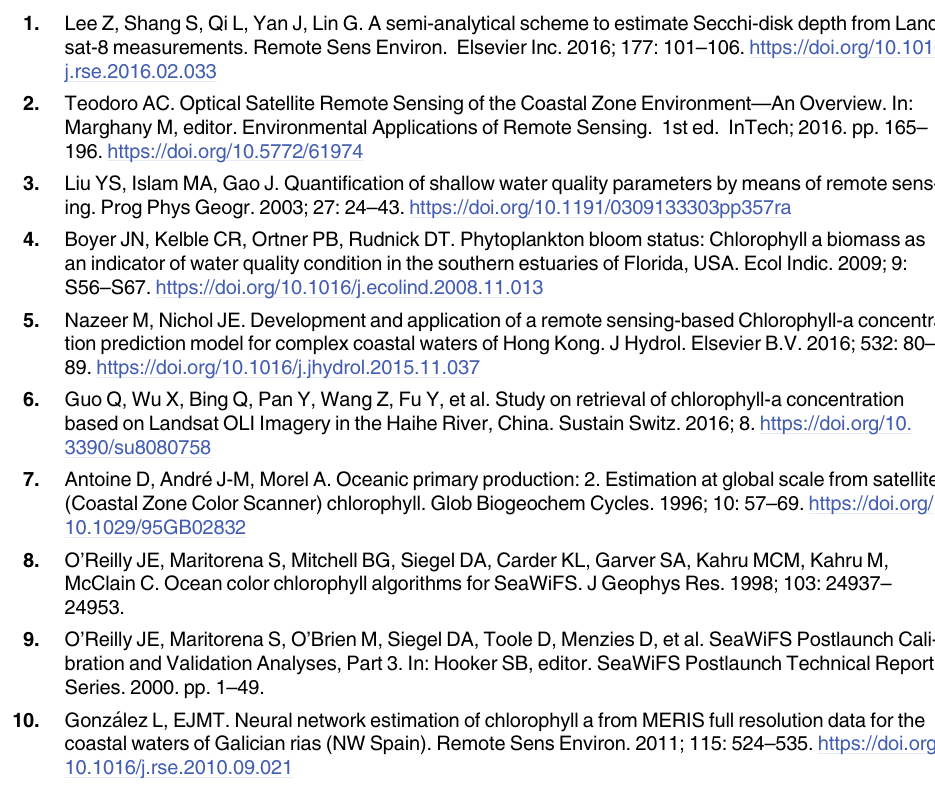
S6 Table. Predictive performance of the GAM